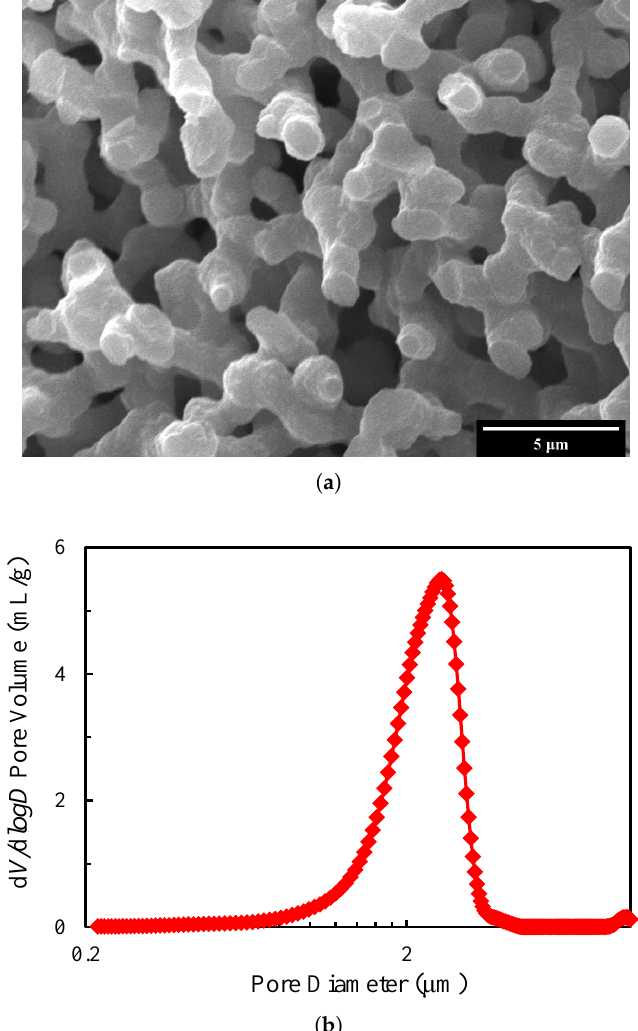
Figure 1. A typical porous silica structure: ( a ) observed through scanning electron microscopy (SEM); ( b ) pore size distribution. Four morphological parameters are considered to represent the microstructure of porous models. (1) Porosity, p , indicates the proportion of the gas phase. In this paper, the porosities of models are limited in the range ( 65% − 85% ) , corresponding to the products prepared by sol-gel method in experiments. = σ (2) Coefficient of variation, C , figures the dispersion of cell size distribution of random V d c / d c structures, where σ and d are the standard deviation of cell diameter and the average equivalent d c c cell diameter respectively. In this paper, the Gaussian unimodal distribution with different standard deviations is used for different cell size distributions. (3) Diameter ratio, t = d , represents the ratio of the cross section diameter between the middle min / d max and the end of a strut, where d and d are the minimum and maximum diameter. Table 1 min max shows the illustration of the struts with different diameter ratios. (4) Normalized curvature, k = r , governs the shape of the cross section of a strut, where r stands c / r s c for the curvature radius of the circumcircle of the cross section and r is the curvature radius of s the sides of the cross section. Table 2 exhibits the illustration of the cross sections with different normalized